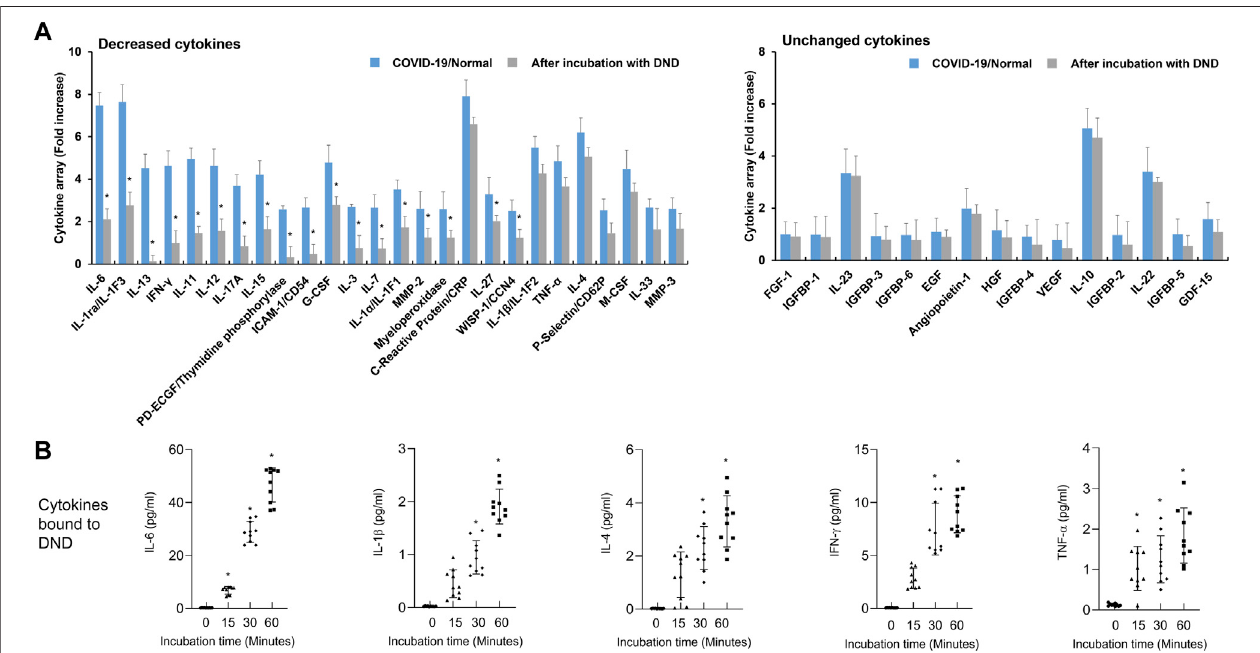
FIGURE 2 | The adsorption ef fi cacy of the highly puri fi ed DND with cytokines in plasma samples of COVID-19 patients ( n = 10). (A) Cytokine array showing which in fl ammatory mediators are adsorbed (left graph) or not (right graph) to the DND from the proteome analysis. (B) The adsorption kinetics of DND with key cytokines including IL-6, IL-1 β , IL-4, IFN- γ , and TNF- α in the plasma of COVID-19 patients ( n = 10). Data are mean ± SEM with signi fi cance set at * p < 0.05 compared to the control